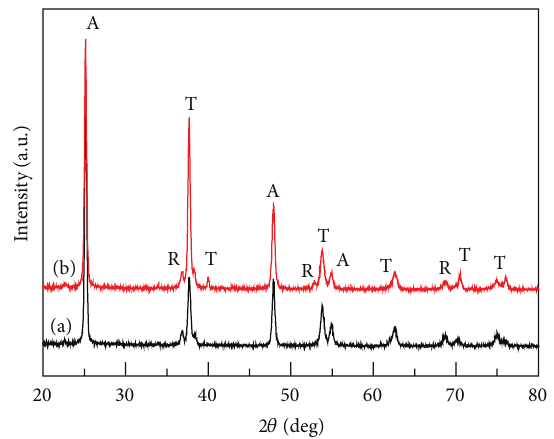
Figure 2: XRD patterns of (a) the TiO 2 nanotube arrays ample annealed at 500 ∘ C and (b) the TiO 2 nanotube arrays ample annealed at 600 ∘ C. A, R, and T represent anatase, rutile, and titanium, respectively.